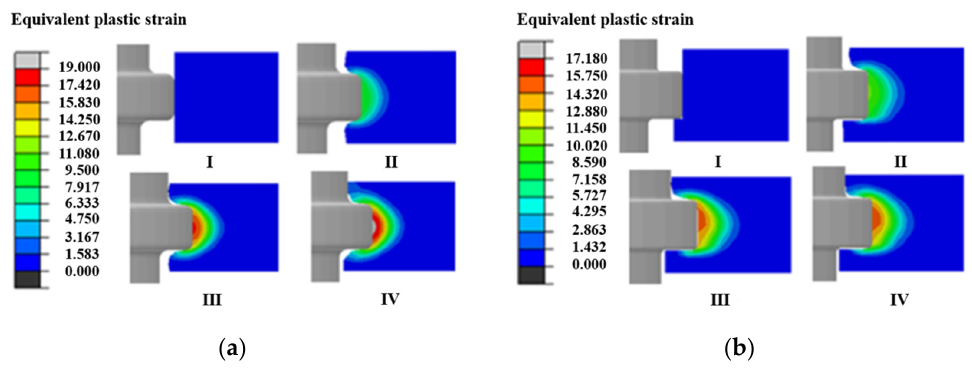
Figure 5. Section shape in three-roll cross-rolling process: ( a ) rectangular cross-section blank; ( b ) trapezoid cross-section blank with permission from [48], 2015, Elsevier.